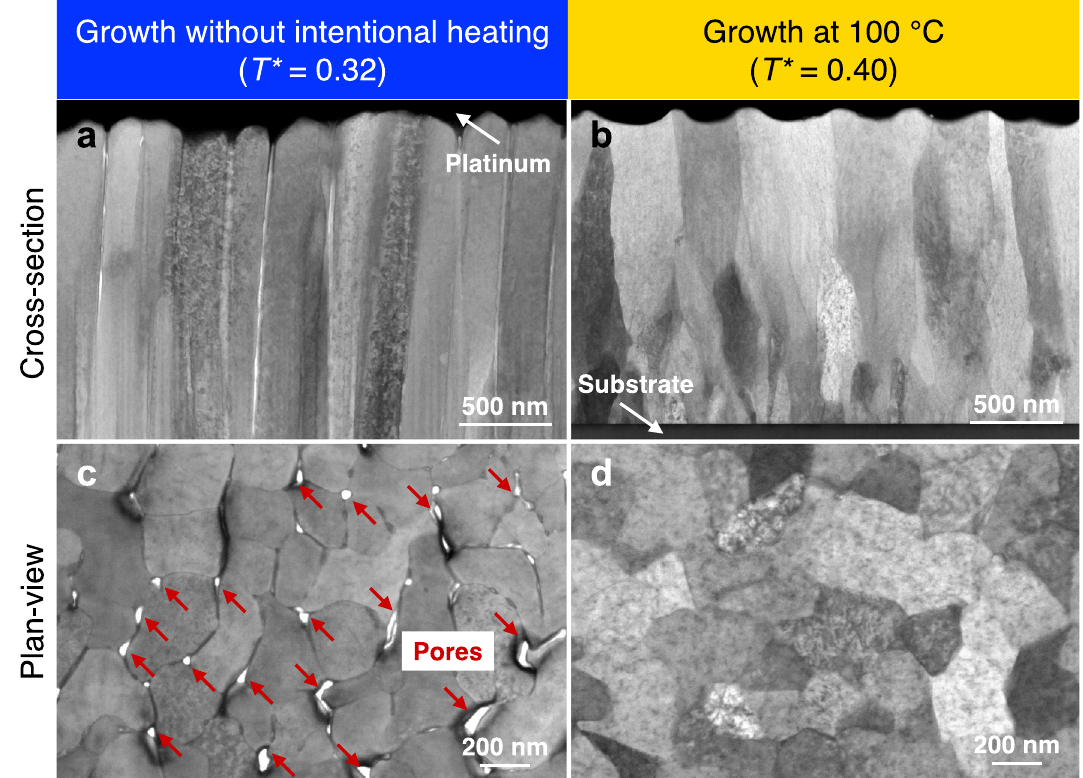
Figure 2. Microstructural characterisation of (Mg,Ca) solid solution thin films grown at different temperatures. Cross-section-views of the thin films ( a ) without intentional heating and ( b ) grown at 100 °C temperature. Plan-views of the thin films ( c ) without intentional heating and ( d ) grown at 100 °C temperature. All images were acquired in bright field mode and the formation of pores at the columnar grain boundaries is evident for T* = 0.32. Homologous temperatures T* = T / T melt were calculated by using the melting temperature of magnesium T melt = 923 K and assuming room temperature (298 K) for the growth scenario without intentional heating as a lower boundary. X-ray diffraction as well as transmission Kikuchi diffraction data can be found in Fig.